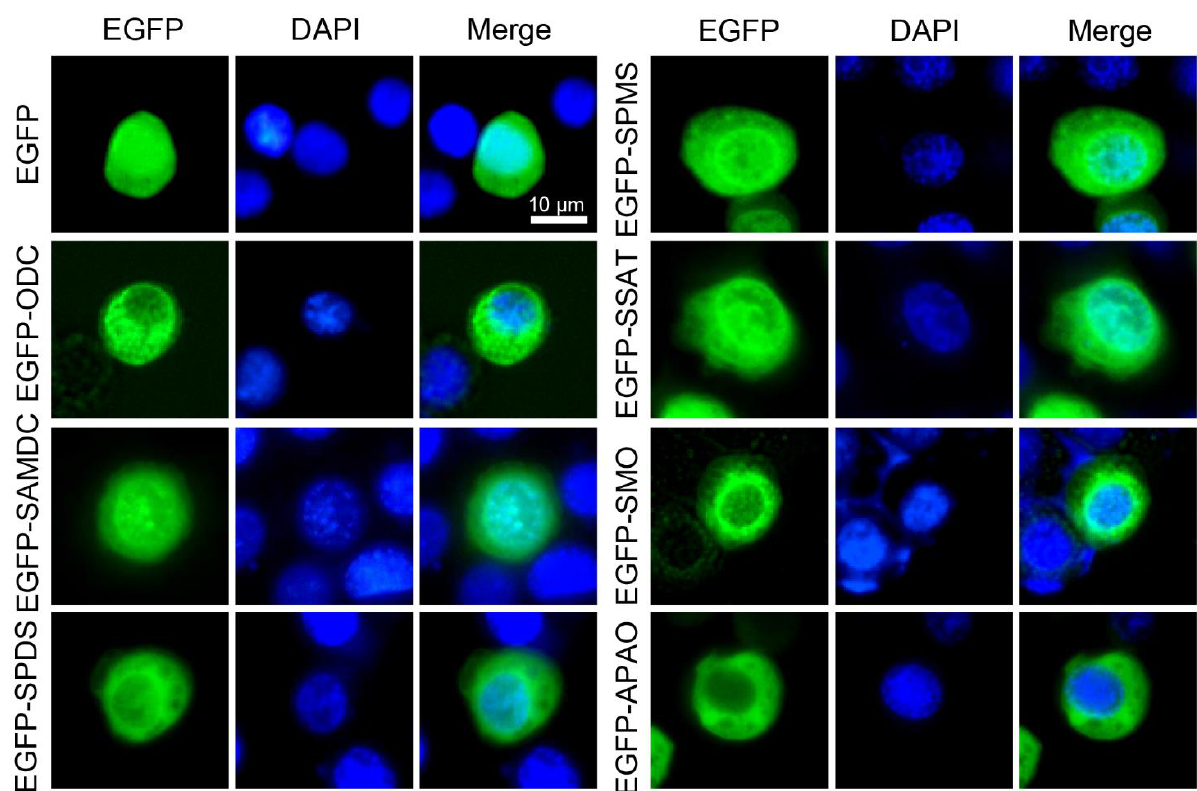
Figure 2. Subcellular localizations of polyamine pathway genes in cultured silkworm cells. Subcellular localization of transiently expressed EGFP-fused polyamine pathway genes in the silkworm BmN cells was determined by fluorescence (green) and the nuclei DNA was counterstained with DAPI (blue). Scale bar, 10 μm.